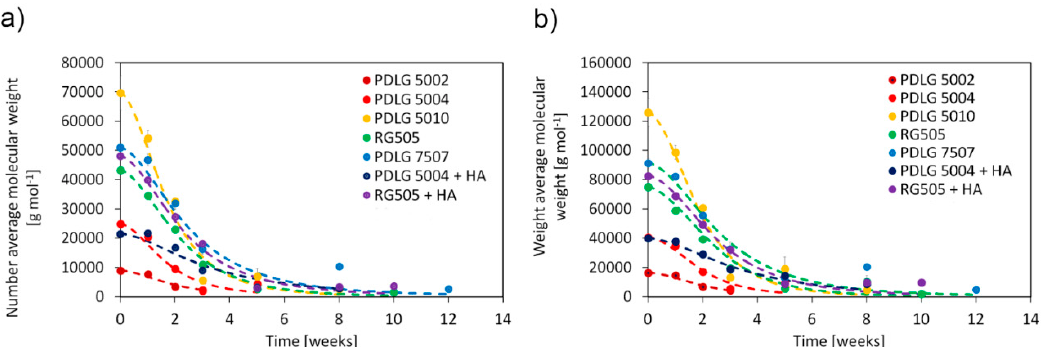
Figure 6. Number ( a ) and weight ( b ) average molecular weights as a function of degradation time: comparison between the experimental data and model results (filled symbols: experimental data; dashed lines: model results).